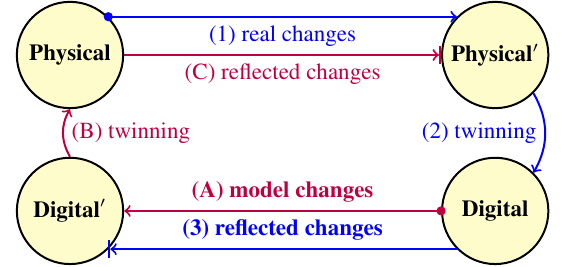
Figure 1. Data flow of changes between a physical entity and its digital counterpart in a digital